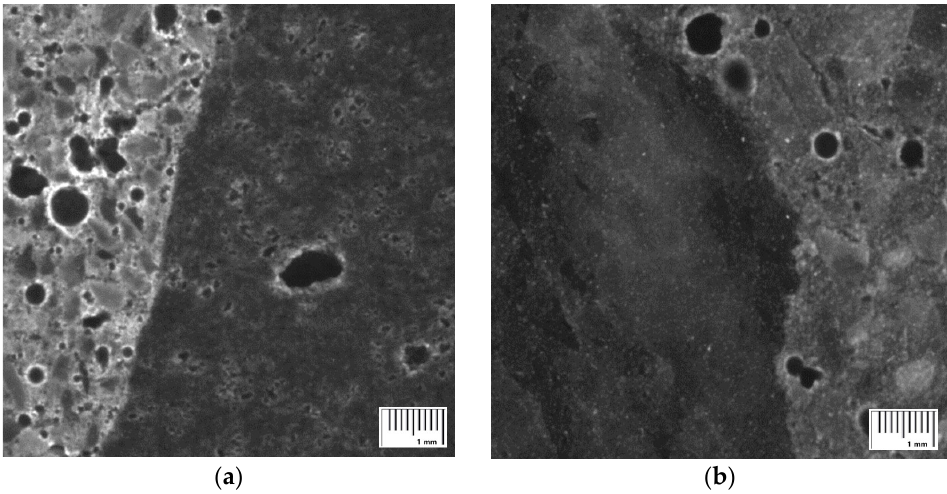
Figure 17. Optical microscope images of concrete. ( a ) Pore of basalt aggregate concrete. ( b ) Pore of quartz aggregate concrete.